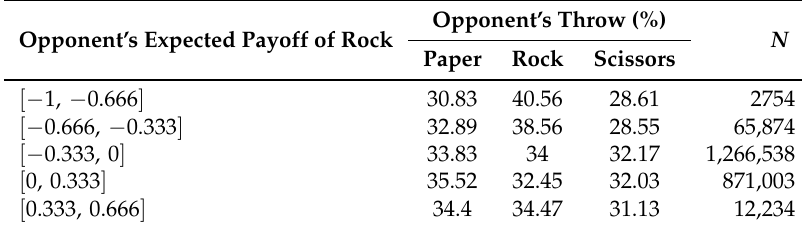
Table 4. Opponents’ Response to Expected Payoff of Rock.